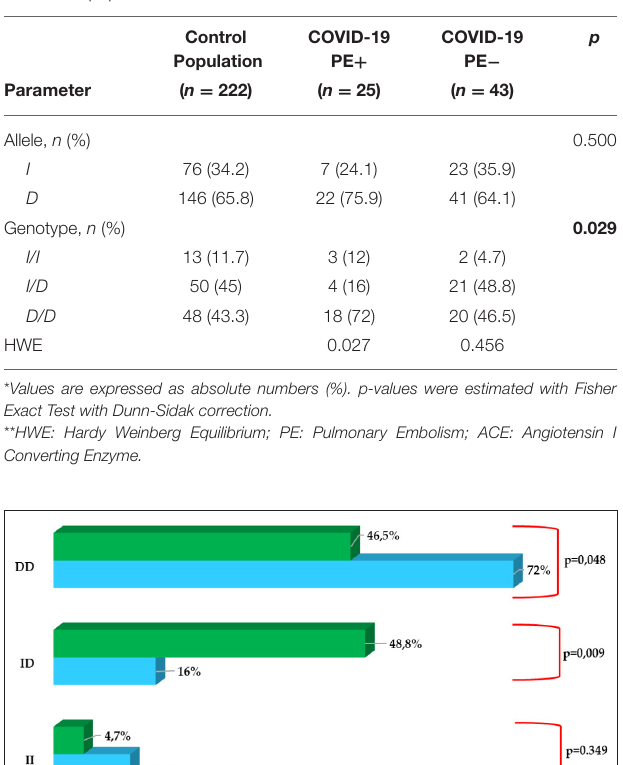
TABLE 2 | Allelic and genotypic frequencies and Hardy Weinberg Equilibrium test for ACE I/D polymorphism rs1799752 in PE + and PE − COVID-19 patients, and in the control population.